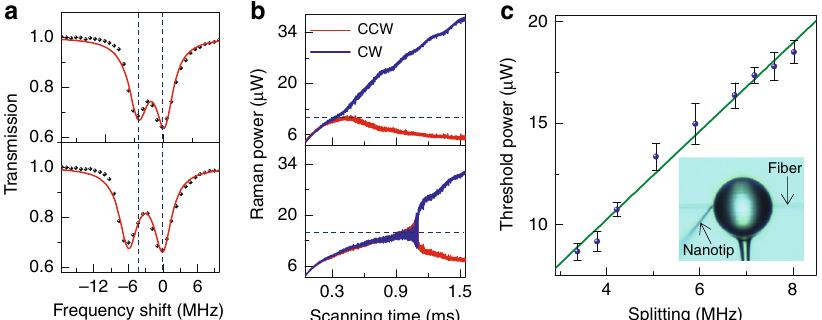
Fig. 4 Symmetry-breaking threshold. a Transmission spectra of Raman modes with a smaller (top) and a larger (bottom) splitting controlled by a side- coupled scatterer, respectively. The black dots (red curves) are the measured ( fi tted) results, manifesting the two standing-wave supermodes featured by the double lorentzian dip. b Raman emission in CW and CCW directions with a smaller (top) and a larger (bottom) Raman mode splitting controlled by a side-coupled scatterer, respectively. c The threshold power for Raman chirality exhibits a linear dependence on the splitting in the Raman modes, where the green line is the fi tting result. The error bars represent the standard deviation of repeated measurements. Inset: A silica nanotip (left side) is placed in the evanescent fi eld of a microsphere to change the Rayleigh scattering